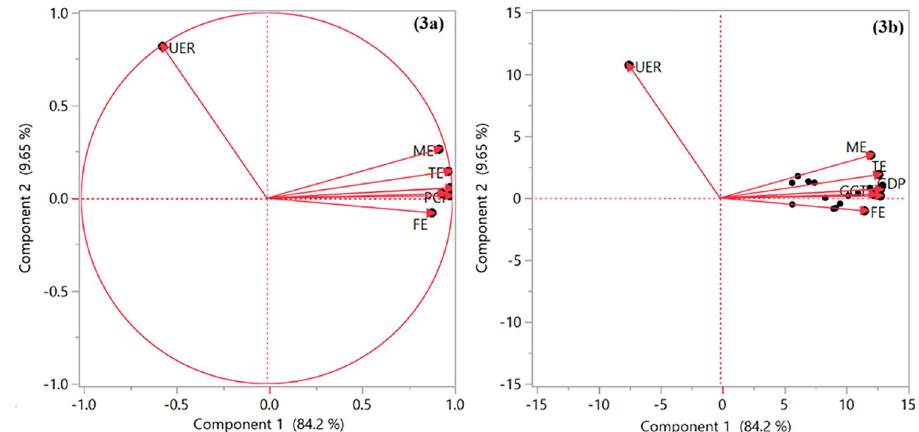
Fig 4. Principal component analysis and biplot showing grouping of variables used in this study. TE: Total enrollment; ME: Male enrollment; FE: Female enrollment; PCI: Parental income; GDP: Gross domestic Production; UER: Unemployment rate; GDPMP: Gross domestic production market price; and GGTE: General government expenditure.